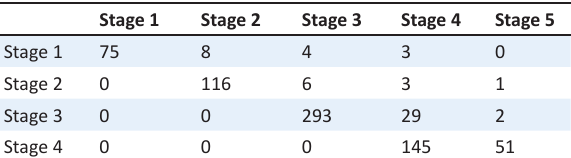
Table 5. Mean sojourn times for misclassification model